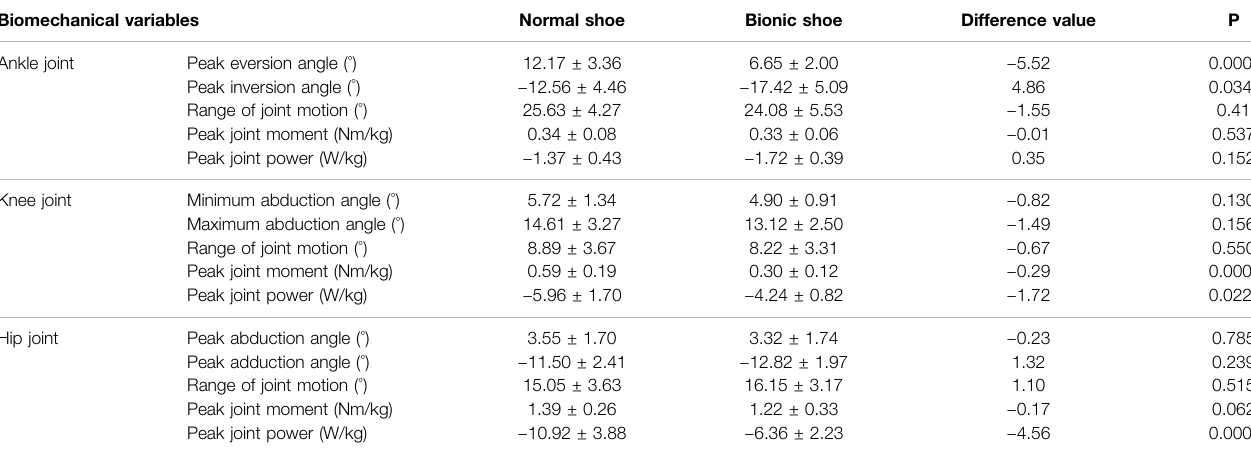
TABLE 2 | Comparison of frontal plane joint angle, joint moment, joint power (means ± standard) between NS and BS during single-leg landing phase. Biomechanical variables Normal shoe Bionic shoe P Ankle